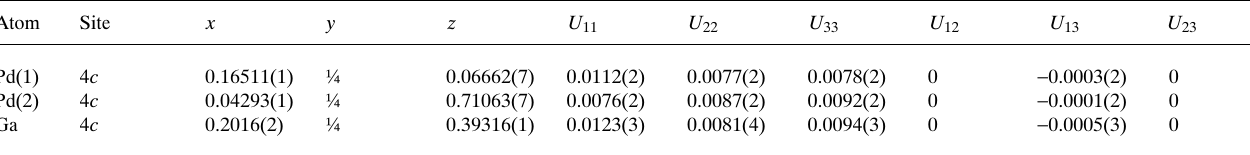
Table 2. Atomic coordinates and displacement parameters (in Å 2 ) .